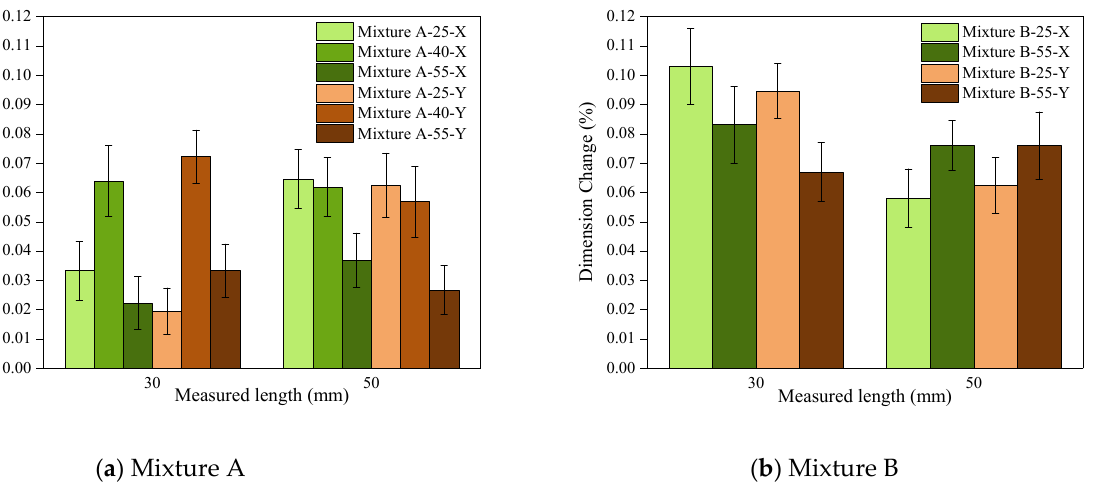
Figure 11. The dimension change of the cross-shaped model printed at different process temperatures upon removal from the platform (susceptibility to deformation), measured in the X and Y directions and at two lengths (30 and 50 mm).